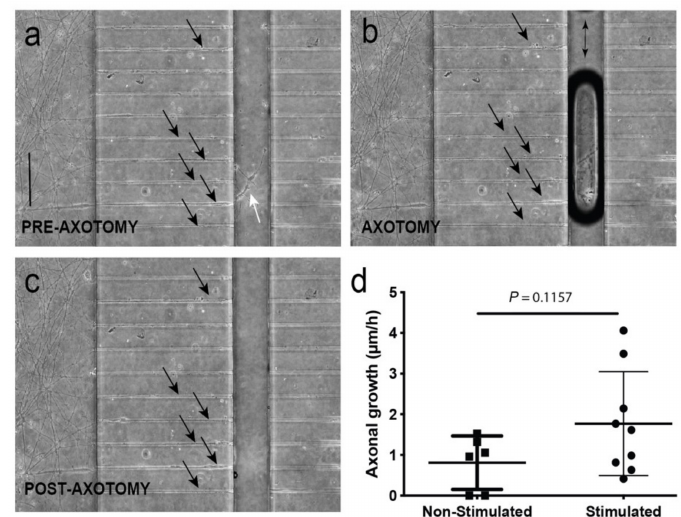
Figure 4. ( a – c ) Representative images of the vacuum-assisted axotomy of the motor neuron (MN) axons using the axotomy channel (before (a), during (b), and after (c)) axotomy. Note the presence of the axons inside the channels during the entire procedure (labelled by arrows in (a–c)) showing the absence of a putative fluidic reflux into the channels, as also demonstrated in Tong et al. (2015) [34] using a similar device with identical channel geometry and fluidic resistance. In addition, note the axotomy of the axons labelled with white arrows (a) located in the axotomy channels and their absence in (c). ( d ) Graph illustrating the mean speed mm / h of identified axons in the axotomy channel between axotomy and 48 h in non-stimulated and stimulated experiments. The stimulation was performed in the ventral horn slices expressing ChR2 in the neuronal reservoir (see Material and Methods for details). Data in (d) are represented as mean ± S.D. The p -value of the statistical analysis is also displayed. Scale bars: (a) = 300 µ m, pertains to (b,c).